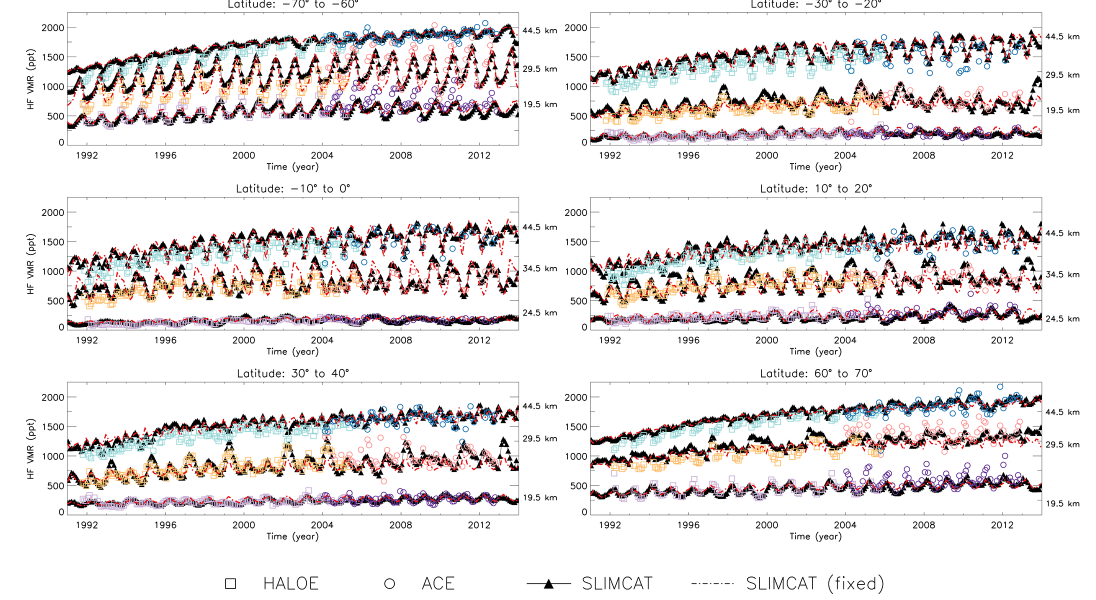
Figure 7. The HALOE, ACE-FTS, and SLIMCAT HF time series for selected altitude–latitude bin combinations. Observations are plotted between October 1991 and December 2012. Overlaid are the time series from a SLIMCAT run with dynamics arbitrarily annually repeating those for the year 2000; this provides a clearer signal of the long-term chemical changes without the complication of variations in stratospheric